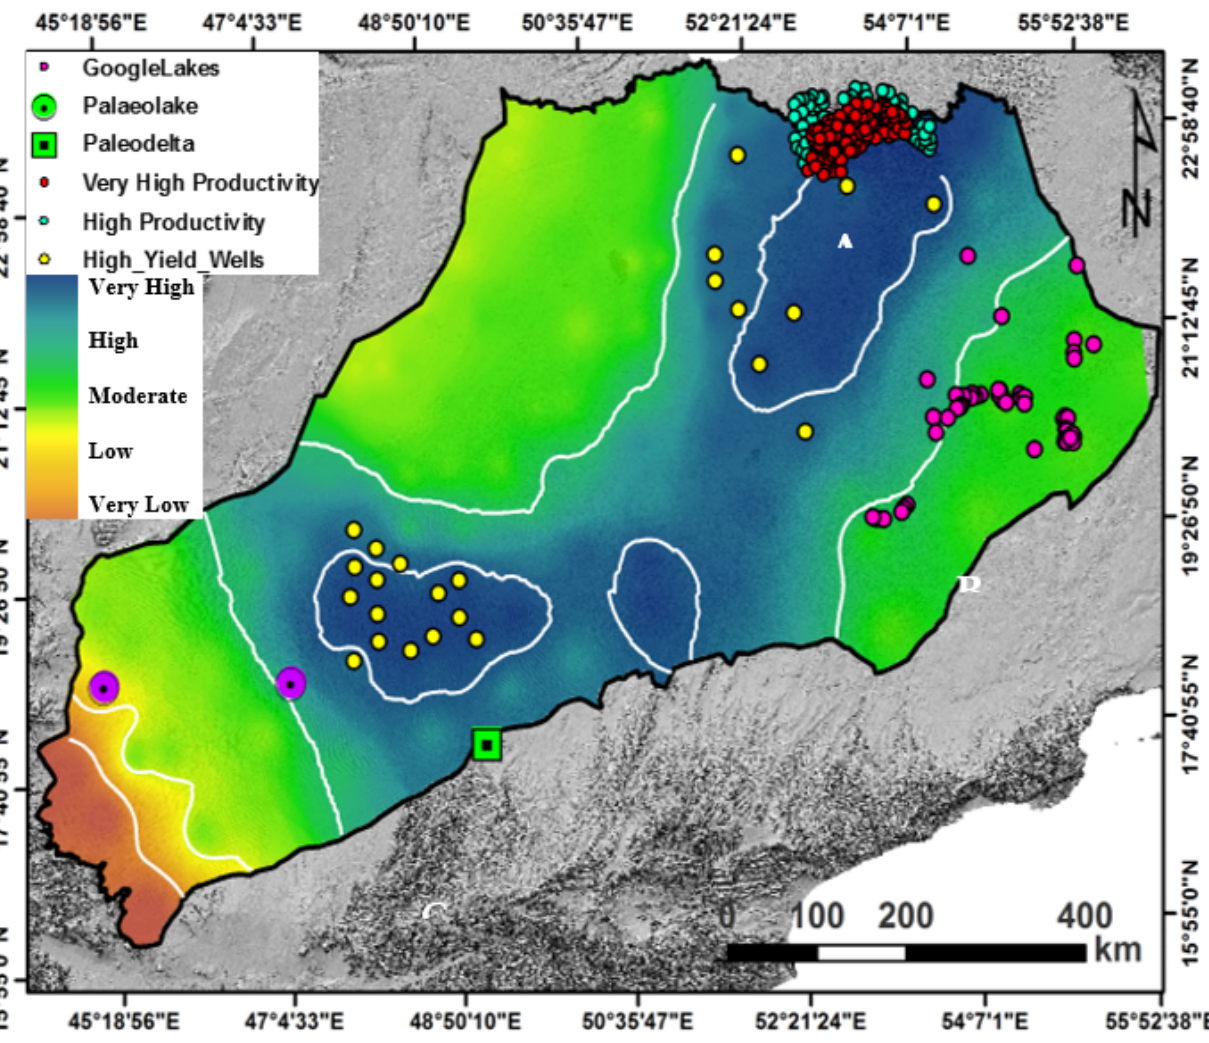
Figure 8. Map of groundwater potentiality of the ARAK underneath sand sheets produced using the CART model. Pink points highlight recovered palaleolake locations and A, B and C point locations used for validation of the resulting GWPM.